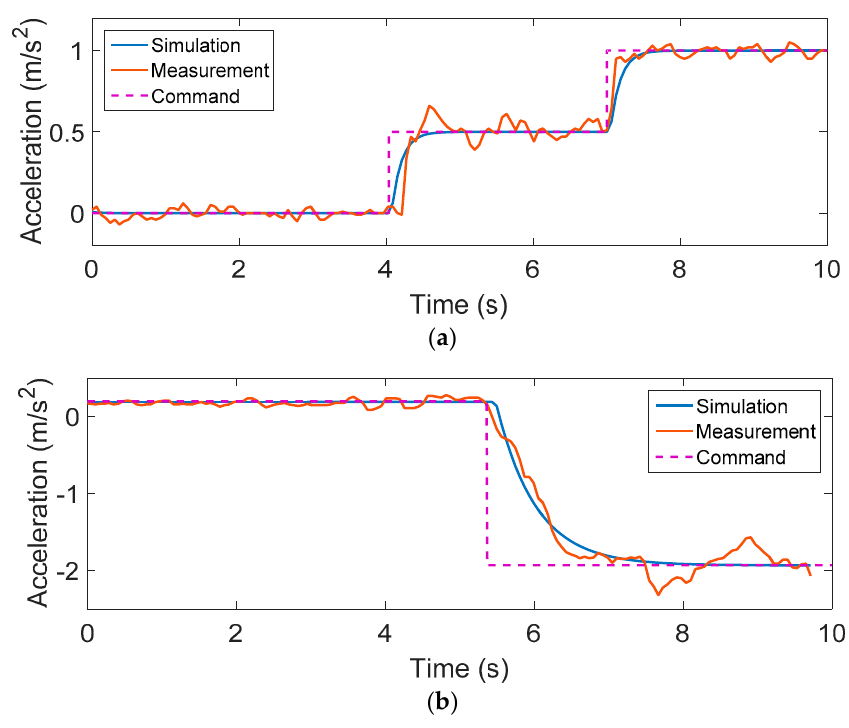
Figure 4. Acceleration response of the host vehicle to the commanded acceleration and simulation output of the model: ( a ) acceleration and ( b ) braking.